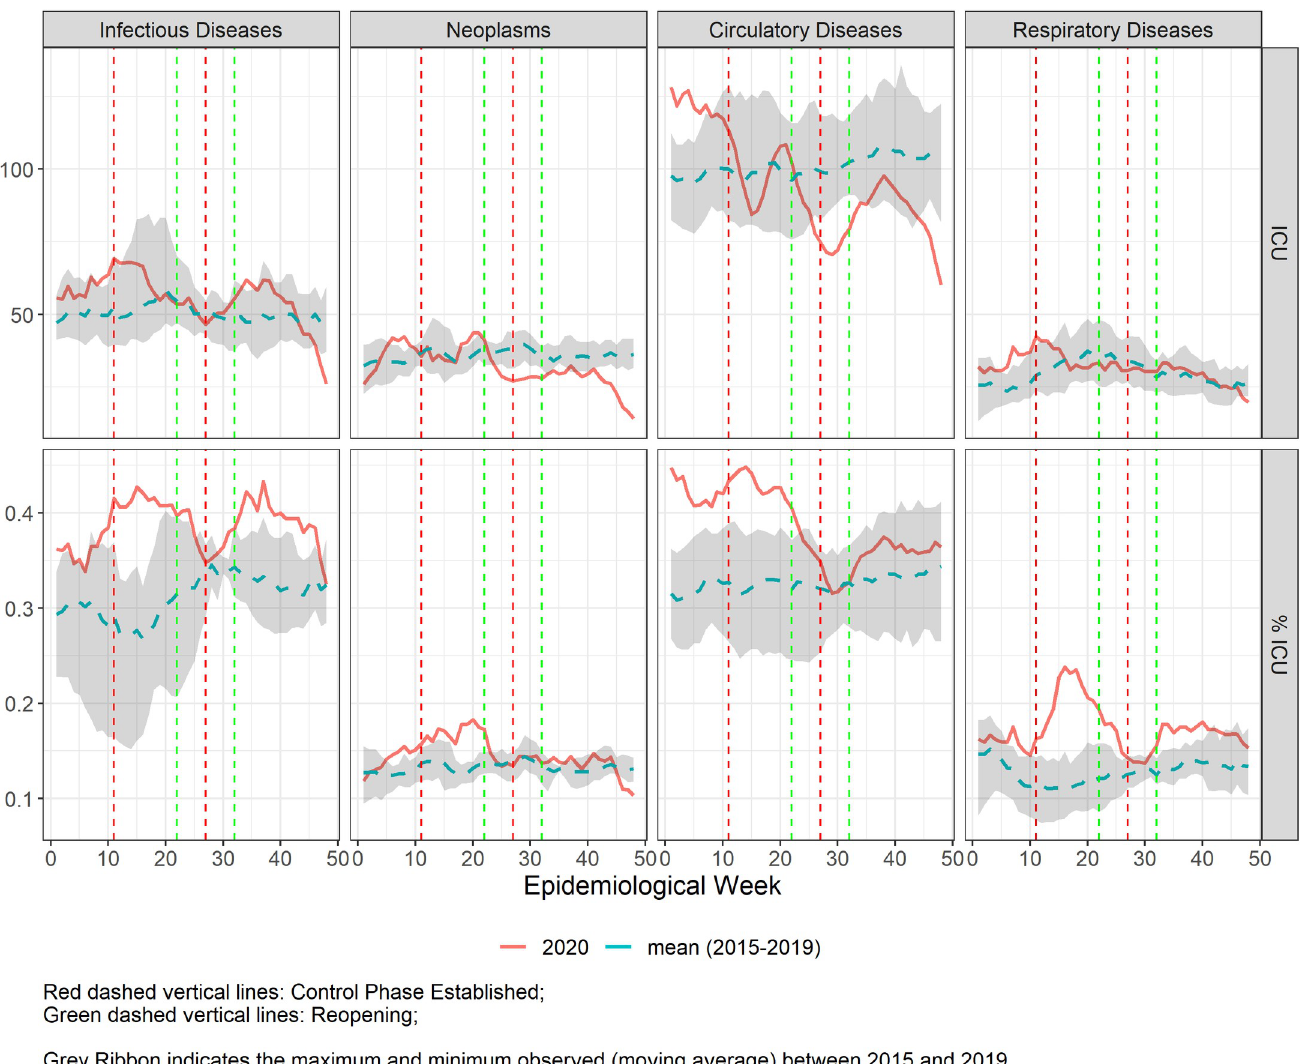
Fig 3. Five-week moving average of number of Intensive Care Unit admissions in Belo Horizonte during the COVID-19 pandemic from epidemiological weeks (EW) 1–48, 2020 (solid line), compared to the mean of 2015–2019 (dashed line), for the 4 selected disease groups. Vertical lines refer to the weeks of control (red) and reopening phases